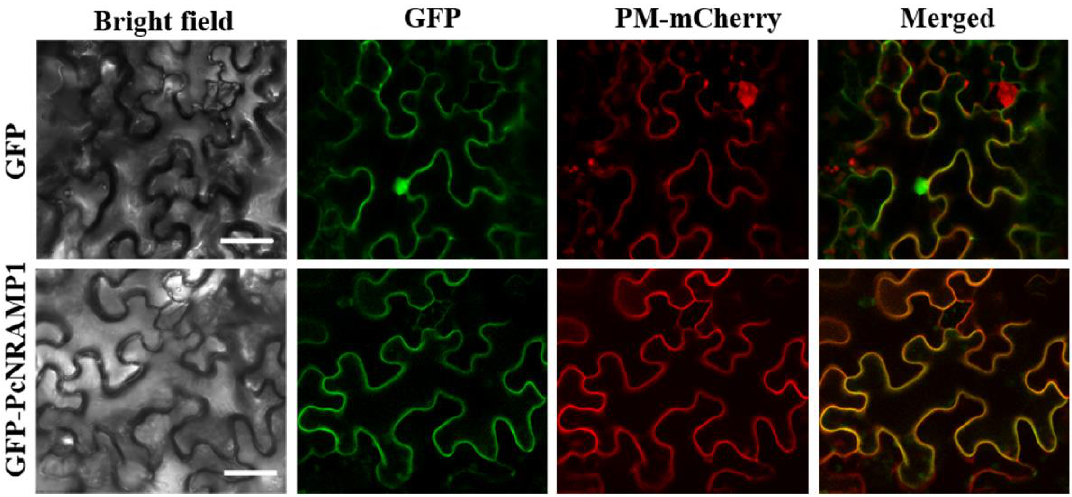
Figure 3. Subcellular localization of PcNRAMP1 in leaf epidermal cells of tobacco. The bright field, the green fluorescent protein (GFP) fluorescence, PM-mCherry and the merged images are shown. Scale bar = 20 μm.